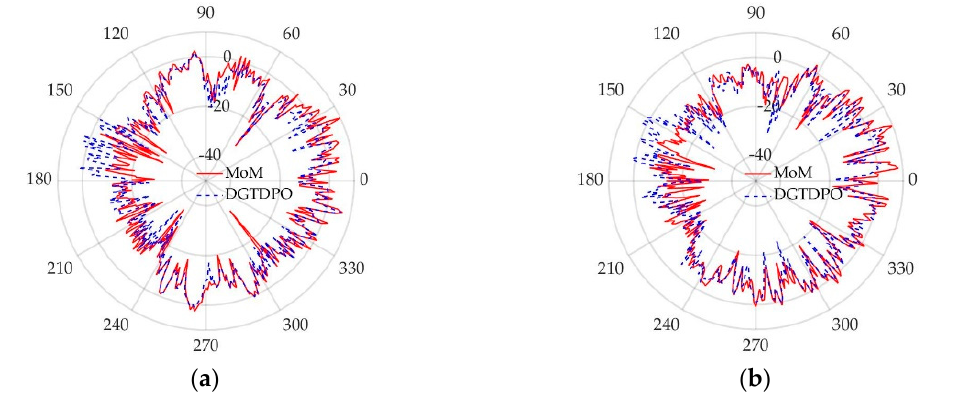
Figure 15. The RCS of the multi-object and sea surface composite computed at ( a ) 1 GHz and ( b ) 1.5 GHz from the solutions of the DGTDPO method and MoM.